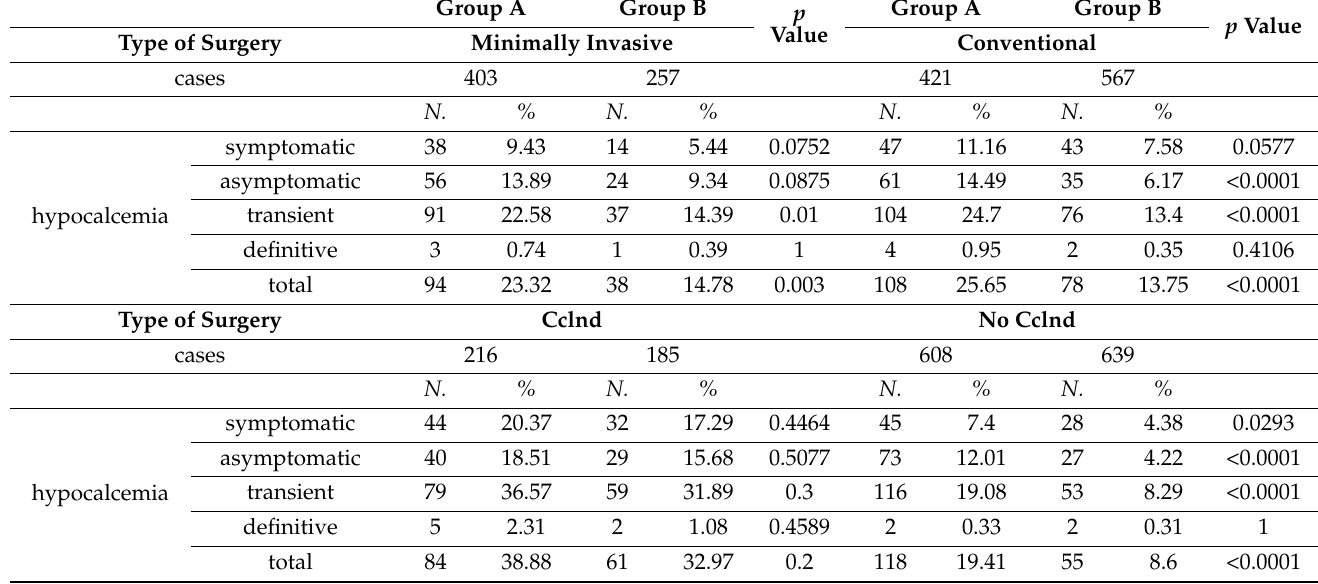
Figure 1. Demographic characteristics of the patients, type of operation and histotype of malignancy, incidences of temporary and permanent hypocalcaemia in the total case series and in the first and second period. Black numbers indicate the number of patients, while red numbers indicate the percentage. Differences between the groups were calculated via the Chi Square, or Fisher’s exact test, when appropriate (both 2-tailed); a p < 0.01 is considered statistically significant. * p < 0.01, ** p < 0.0001. Table 1. Comparison of conventional and minimally invasive procedures and of patients who received only a total thyroidectomy versus those in whom a central compartment lymphectomy was also performed, whether or not extended to the lateral compartments.